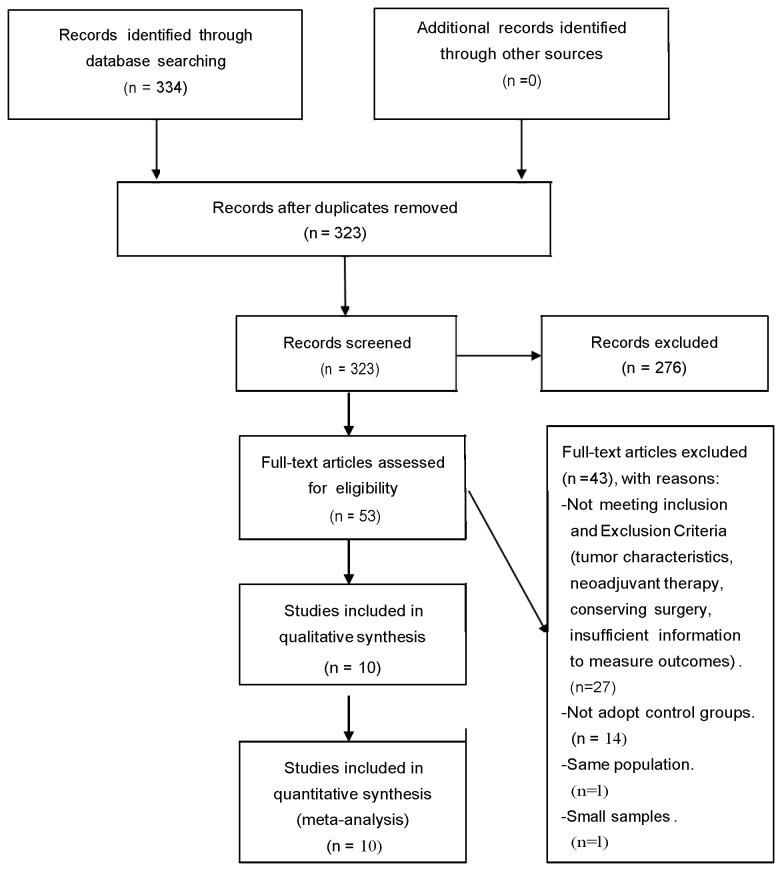
Flow diagram of this meta-analysis.